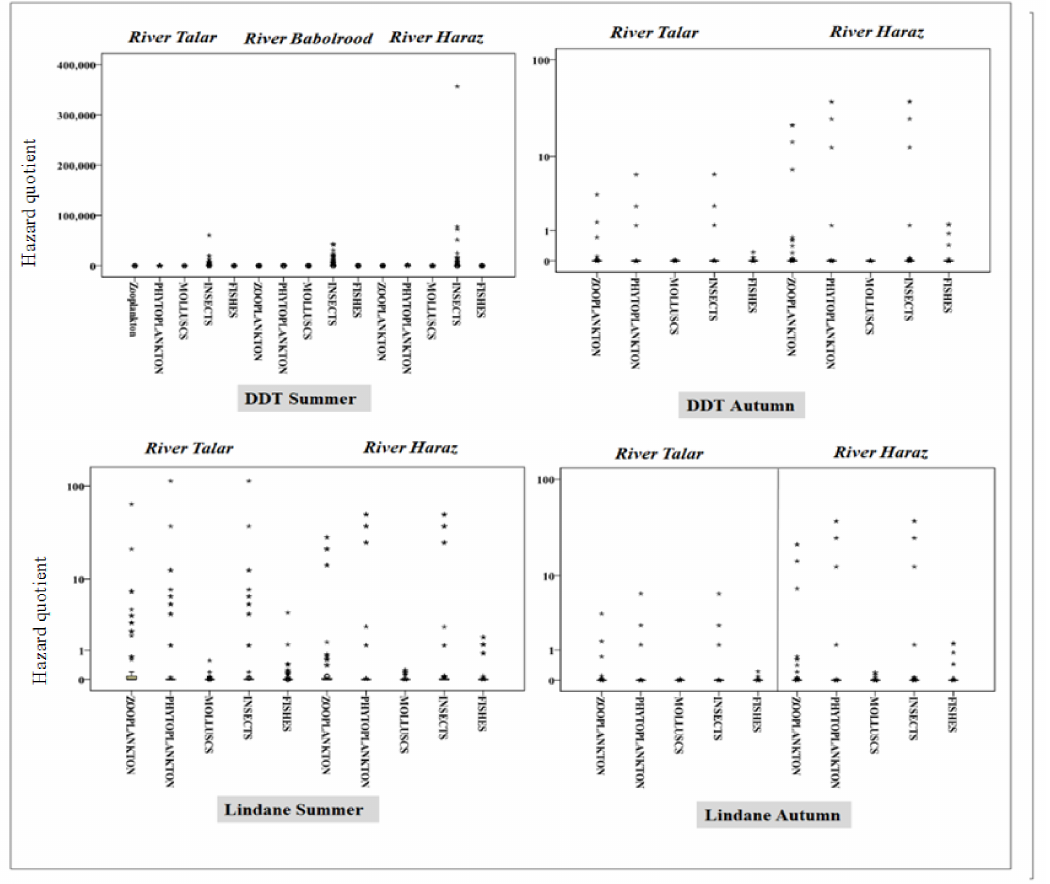
Figure 5. Boxplot showing the range of hazard quotient for organisms in different trophic levels, viz. phytoplankton, zooplankton, insect, mollusk and fish, due to detected concentrations of DDT and lindane in surface water in Talar, Haraz and Babolrood Rivers. Hazard quotient more than 1 indicates ecotoxicological concern to the organism. Hazard quotient = MEC / PNEC (MEC, measured environmental concentration; PNEC, predicted no-effect concentration; see Material and